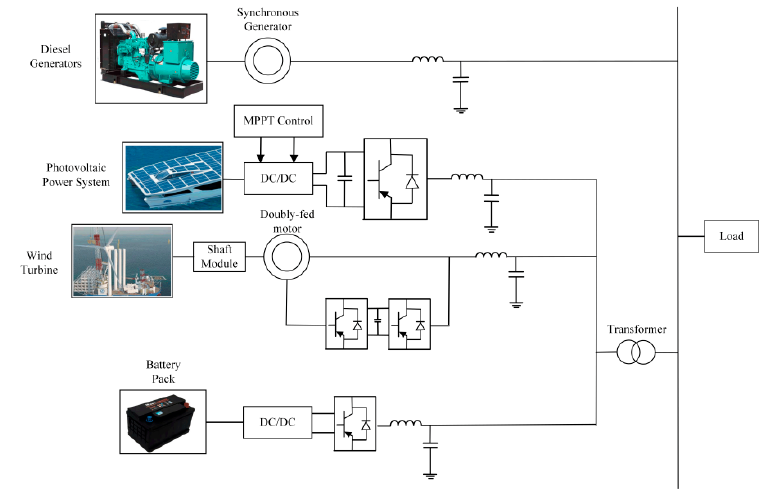
Figure 1. Typical system structure diagram.